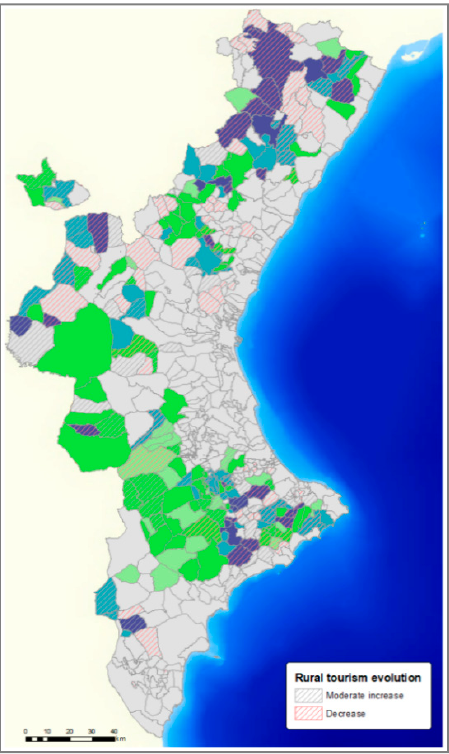
Figure 13. Relationship between municipalities with suitable land for swine sector development and municipalities with low evolution of rural tourism.